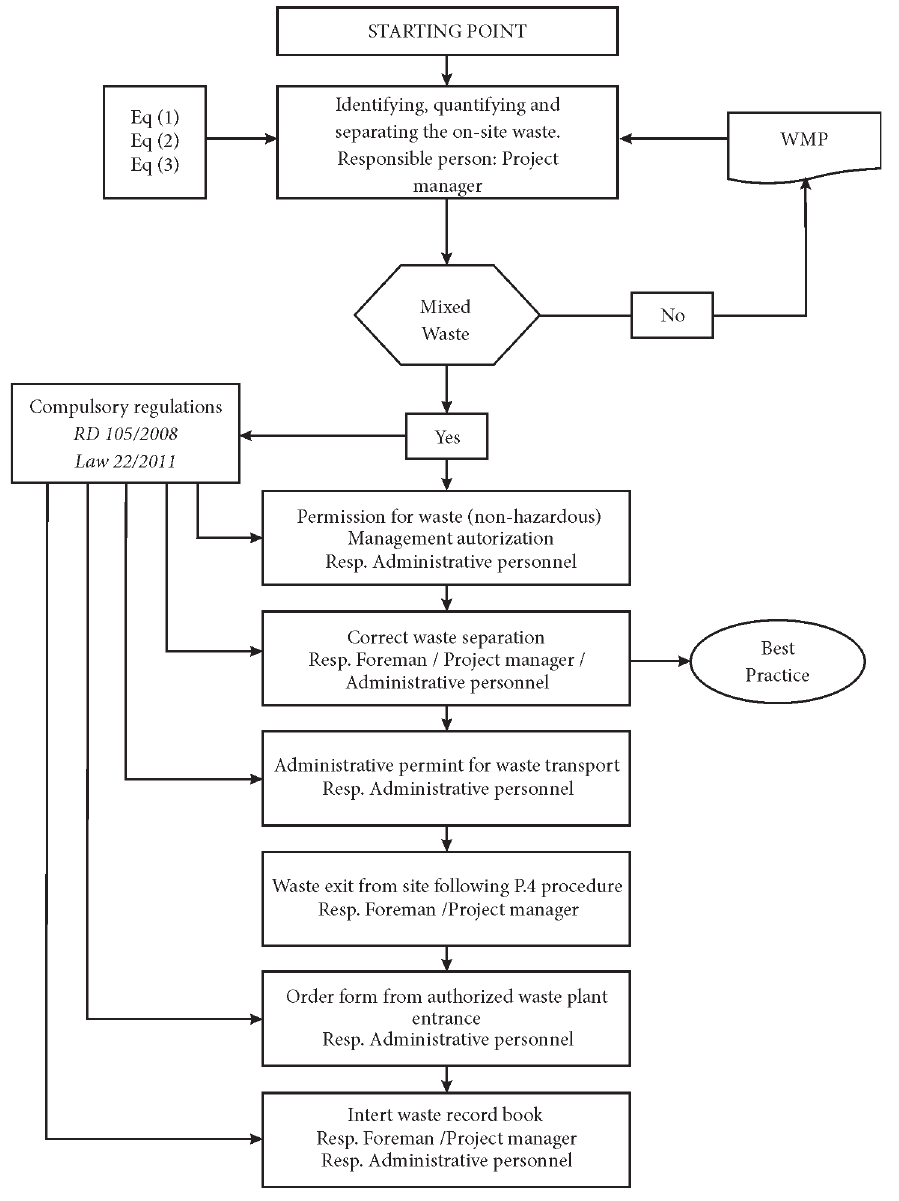
Fig. 3. Flowchart for mixed C&D waste management